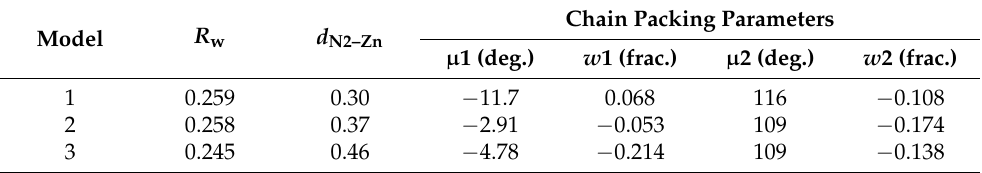
Table 3. Chain packing parameters and R w values of models selected in three-dimensional struc- ture